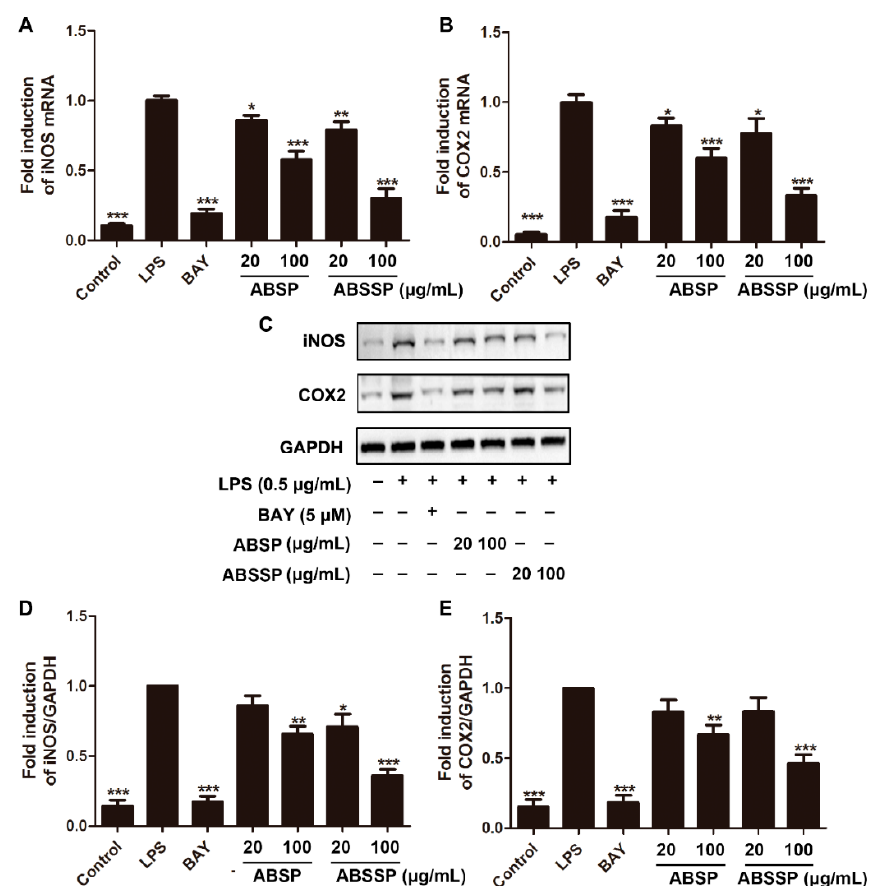
Figure 4. Effects of ABSP and ABSSP on mRNA and protein expression of inducible nitric oxide synthase (iNOS) and cyclooxygenase 2 (COX2) in LPS-stimulated RAW264.7 macrophage cells. RAW264.7 cells were pretreated with ABSP, ABSSP (20 and 100 μ g/mL), and BAY11-7082 (BAY, 5 μ M) for 2 h, and then stimulated with LPS (0.5 μ g/mL) for 24 h. The mRNA levels of iNOS ( A ) and COX2 ( B ) were measured by qRT-PCR; Glyceraldehyde-3-phosphate dehydrogenase (GAPDH) was used as an internal control. Cell lysates were immunoblotted with anti-iNOS and anti-COX2 antibodies. GAPDH was used as a loading control. Results from representative experiments are shown ( C ), and the quantitative results of iNOS ( D ) and COX2 ( E ) are depicted. Data are expressed as mean ± SD, n = 3. * p < 0.05, ** p < 0.01, *** p < 0.001, compared with LPS.2.4. ABSP and ABSSP decreased the mRNA expression of interleukin 1 β (IL-1 β ) and tumor necrosis factor α (TNF- α ) in LPS-activated RAW264.7 cells.